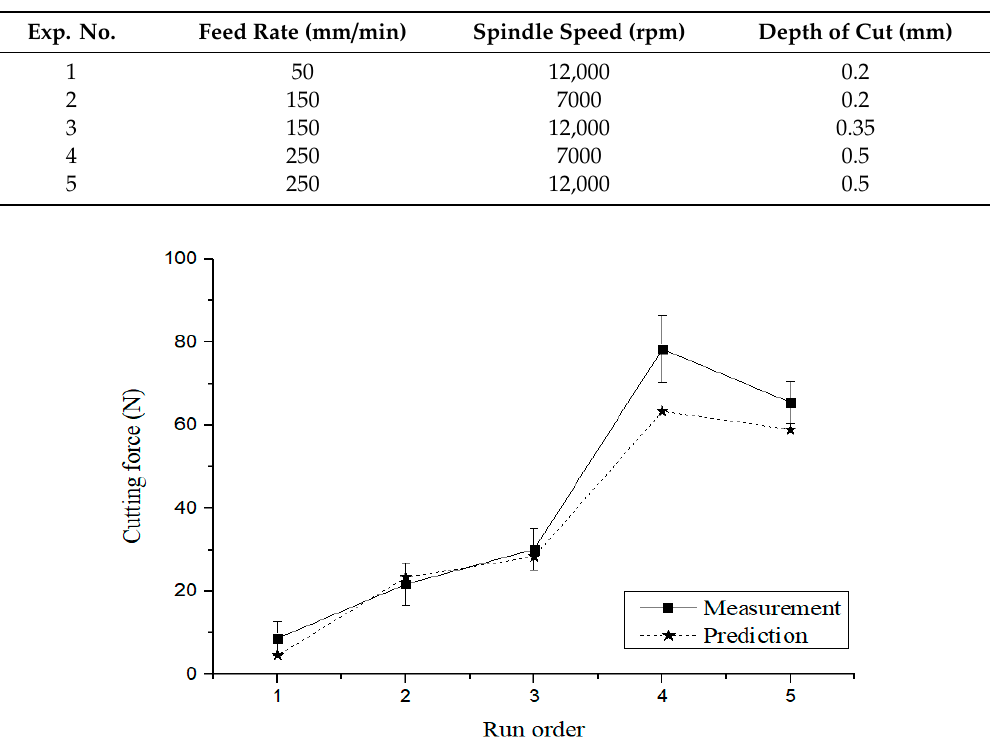
Figure 10. Comparison of the results of the prediction equation and the verification experiments for the cutting force.